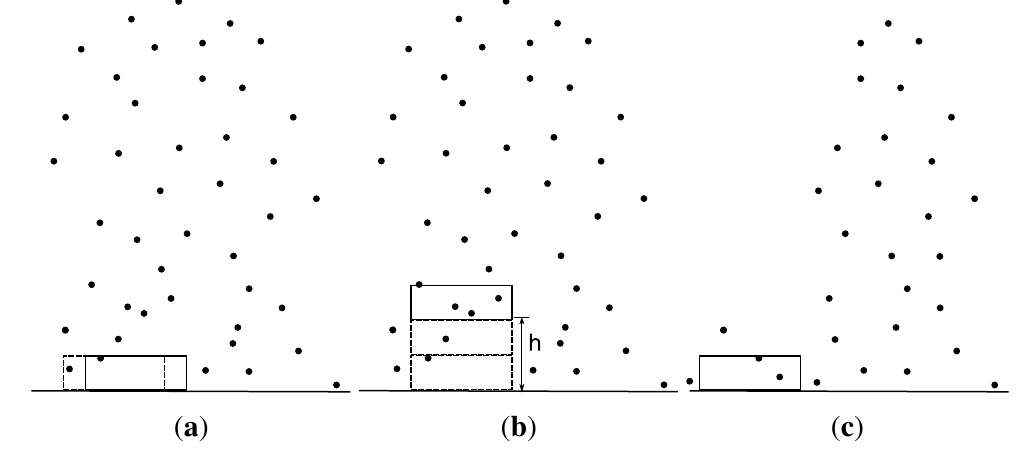
Figure 5. Detecting and estimating the height of a gap (side view): ( a ) a gap has been located (the number of points in the voxel is less than or equal to the point threshold, which was 2 in this example); ( b ) the height of the gap (marked as h) is estimated by using vertical voxel movement; ( c ) an example of a gap formed due to the absence of vegetation at a location. The dashed boxes represent the position of the voxel before